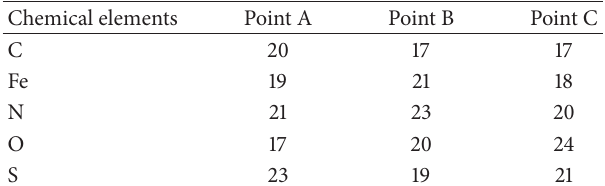
Table 4: Chemical composition (%) of MO formed within SC in industrial plant located in Mexicali as in Figure 4(b) (2011).